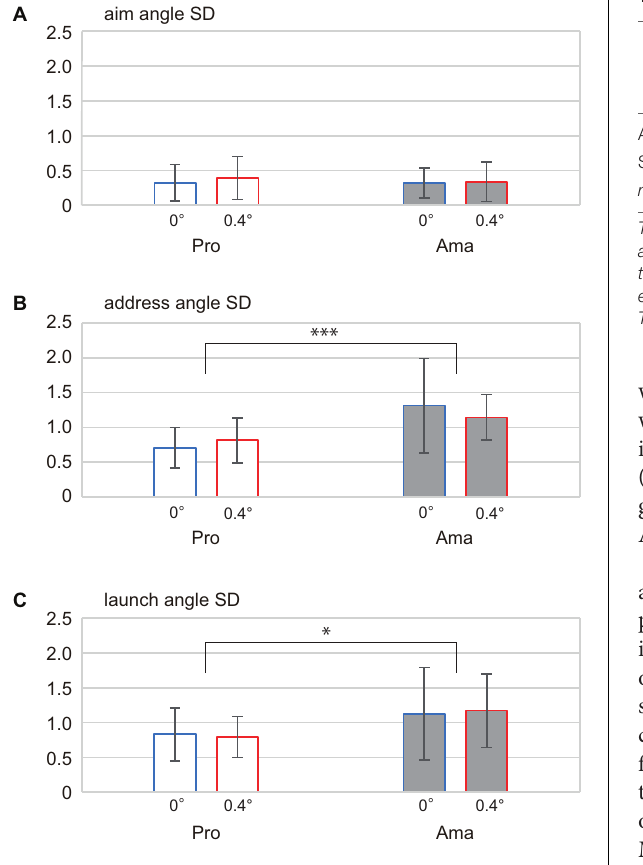
TABLE 3 | Average ball launch angles and impact velocities in the hole-in